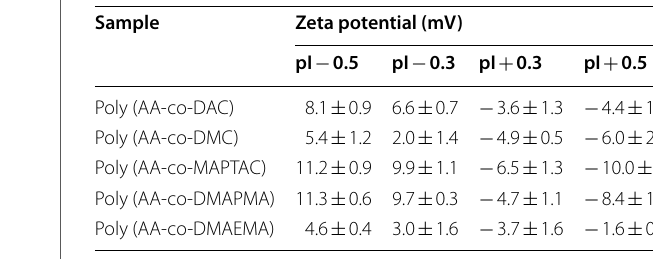
Table 3 Zeta potentials of AAPs near the pI